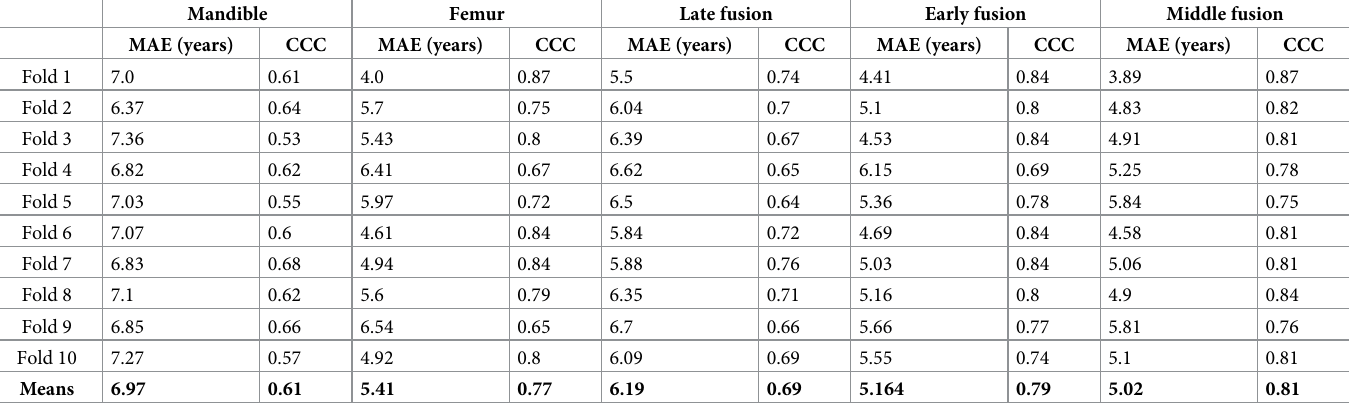
that obtained when using femur and mandible alone; the standard deviations were 0.26 and 0.34 for late and middle fusion, respectively. Meanwhile, the mandible yields the worst stan- dard deviation, which was 0.51. In the case of the CCC metric, the mandible also obtained the highest standard deviation (0.05). By contrast, the standard deviation of all femur, late fusion, and middle fusion were 0.03. This proved the stability of using the ensemble technique. We also evaluated the effectiveness of the gender features. In fact, owing to the small dataset size, we had to augment both the male and female samples. In our case, we have 685 male and 185 female samples. The female sample size is quite small for DL; therefore, we merely per- formed more experiments using the male samples with the same configuration. As shown in Table 3, when using middle fusion, we achieved the best accuracy in terms of MAE and CCC with corresponding means equal to 5.02 and 0.81, respectively. Further, the comparison of results from Resnet, MobileNet, and SqueezeNet for extracting femur features is presented in Table 4. Table 3. Age estimation results for mandible and femur alone, and their corresponding fusion results using only male samples. Mandible Femur Late fusion Early fusion Middle